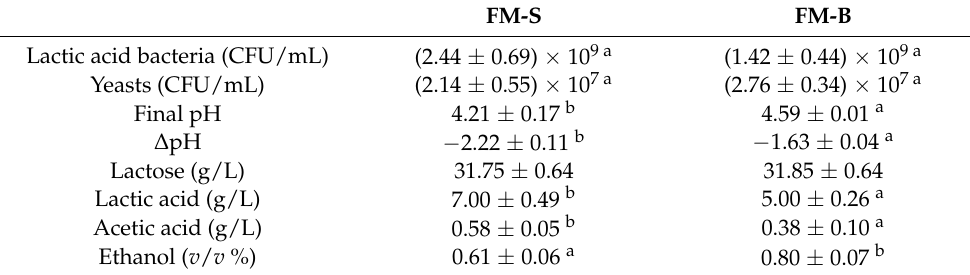
Table 1. Microbiological (total lactic acid bacteria and yeasts) and chemical (pH, lactose, ethanol and organic acids) features of fermented milk after 24 h of fermentation. FM-S: fermented milk obtained by the direct inoculum of the starter; FM-B: fermented milk obtained by previous fermented batch of fermented milk as inoculum. ∆ pH: difference between the final and initial value of pH. Results are expressed as mean ± standard deviation (n = 3). Different letters in the same raw correspond to significant differences ( p <